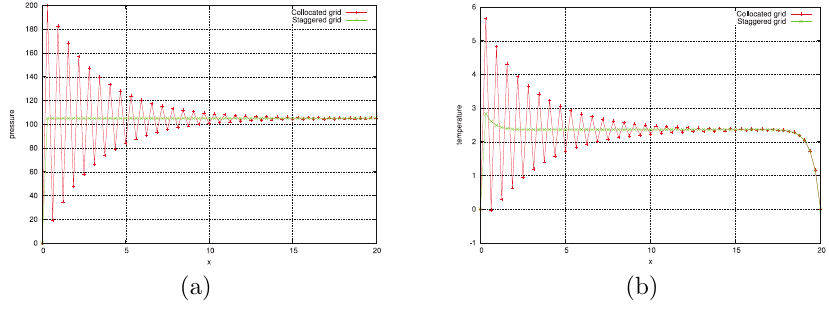
Figure 1. Approximation solutions for pressure (a) and for temperature (b) using collocated and staggered grids for the column